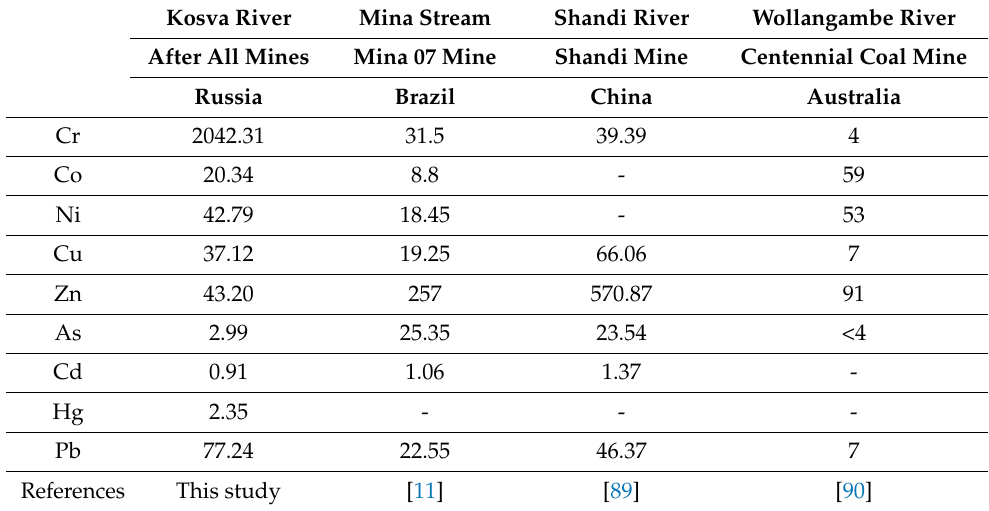
Table 11. Integrated data on trace element content in sediments in places of AMD discharge